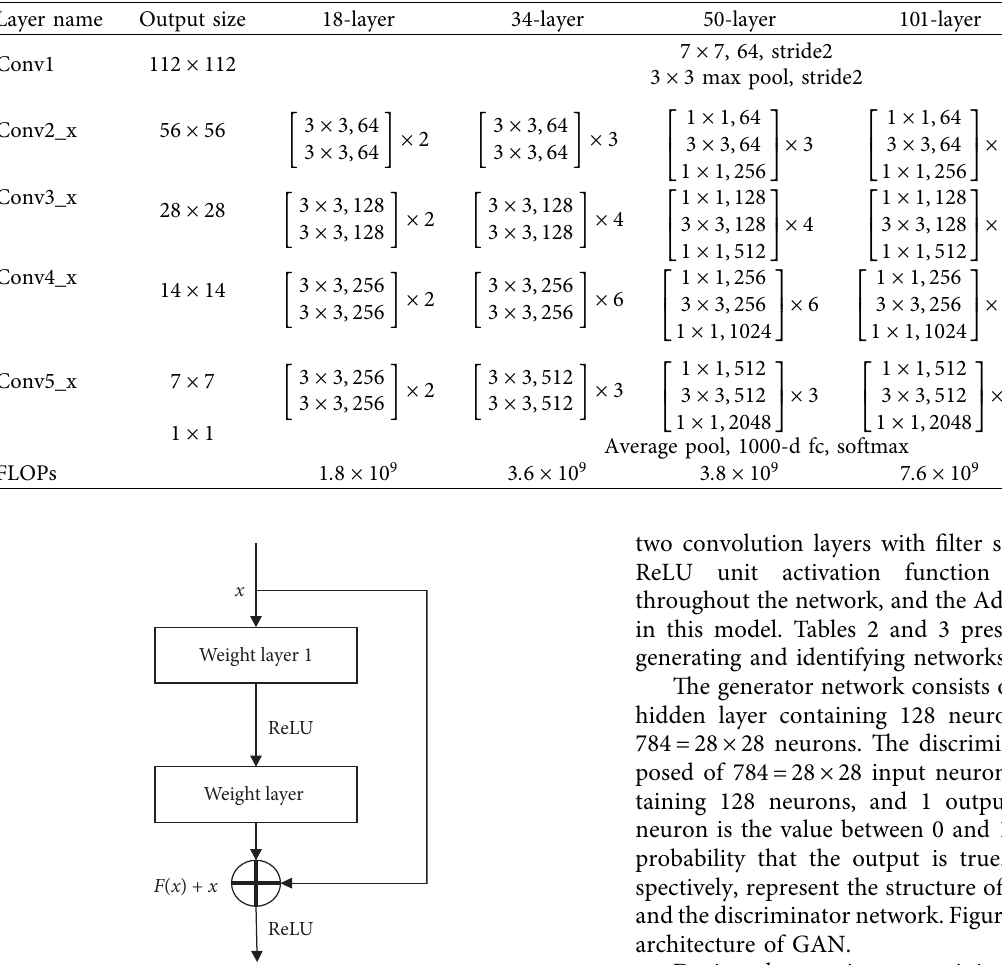
Figure 3: Residual learning